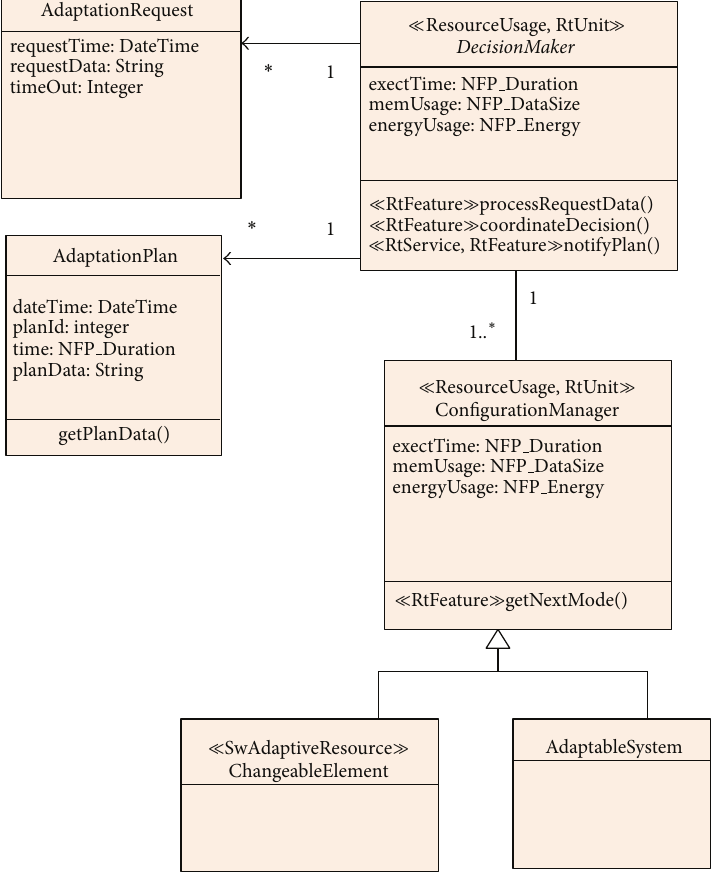
Figure 7: Structural view of the RTE DecisionMaker